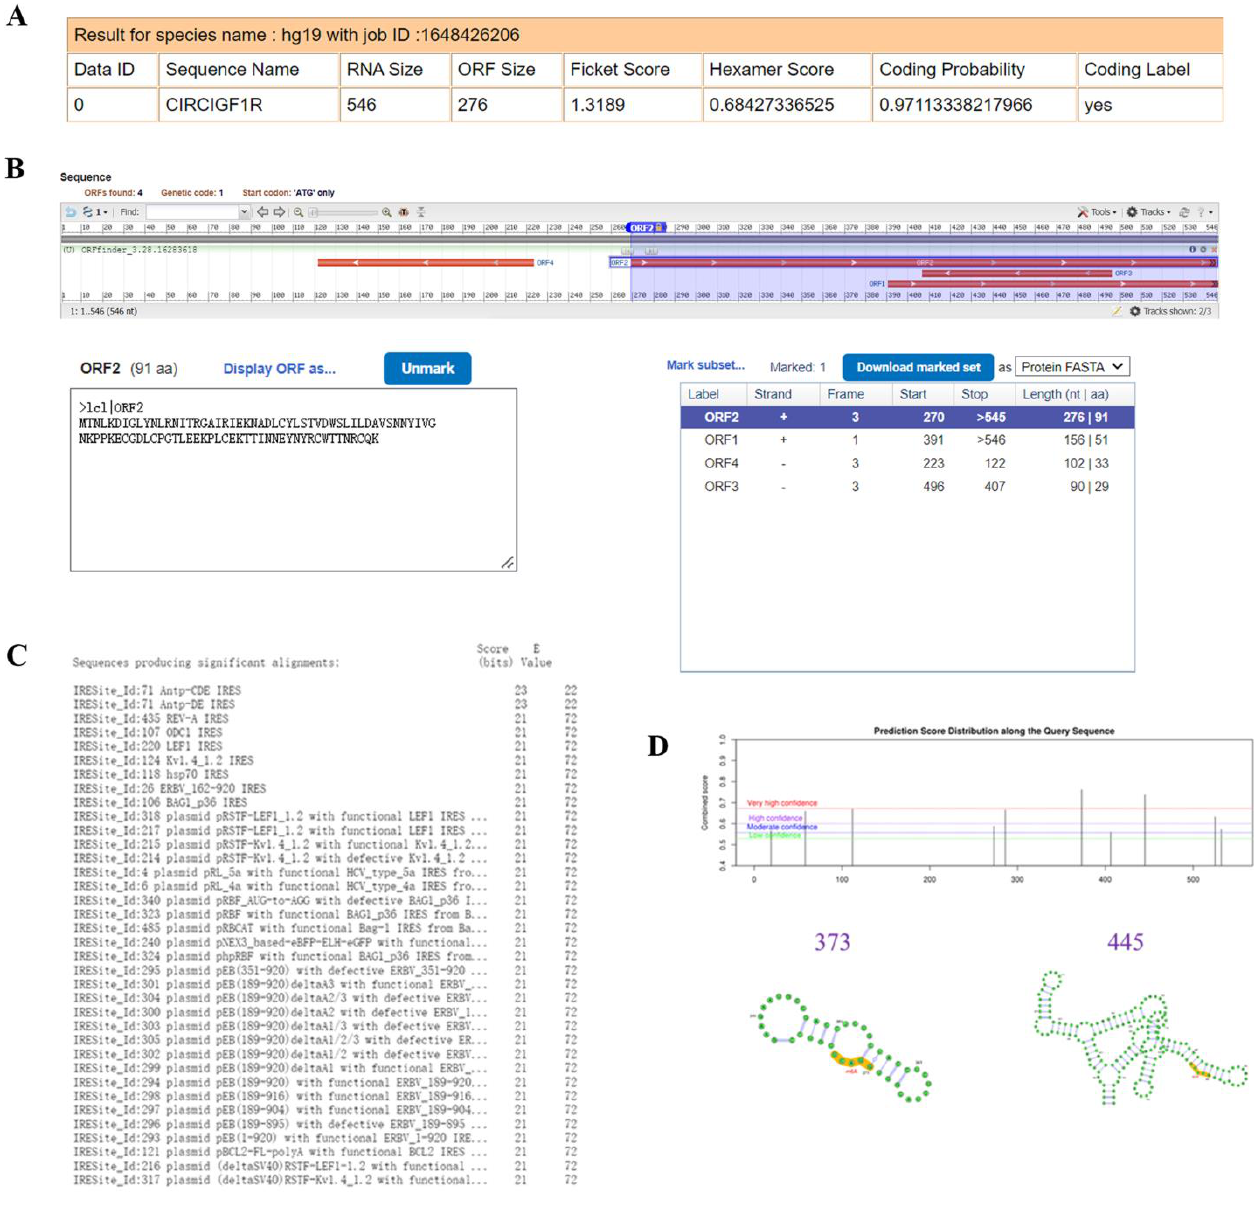
Figure 8. Prediction of the translation ability of circIGF1R. ( A , B ): Translation ability and ORF prediction of circIGF1R. ( C ): IRES prediction of circIGF1R. ( D ): m6A site prediction of circIGF1R.